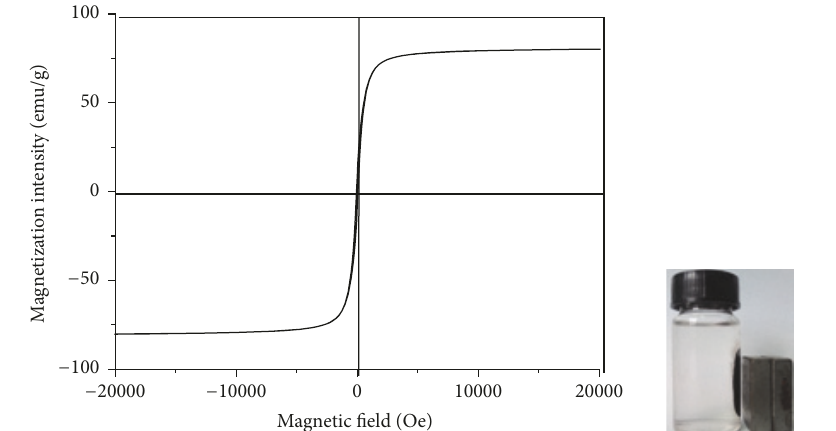
Figure 5: The hysteresis loop of Fe 3 O 4 /GO.